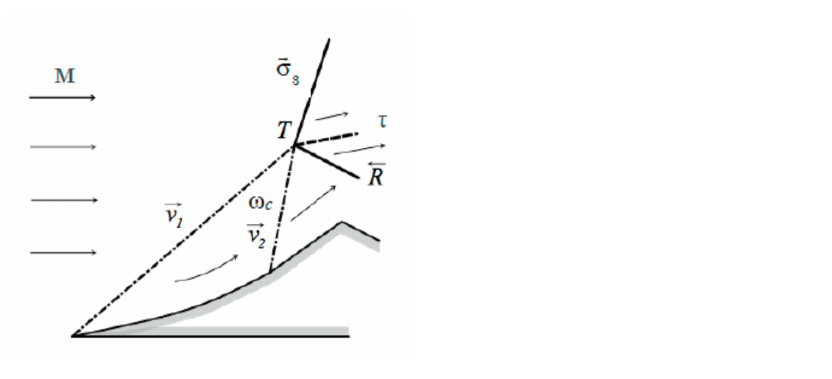
Figure 7. Centered compression wave ω c as a limiting case of multiple discontinuities in one direction ( ν 1 and ν 2 are discontinuous characteristics that limit the centered compression